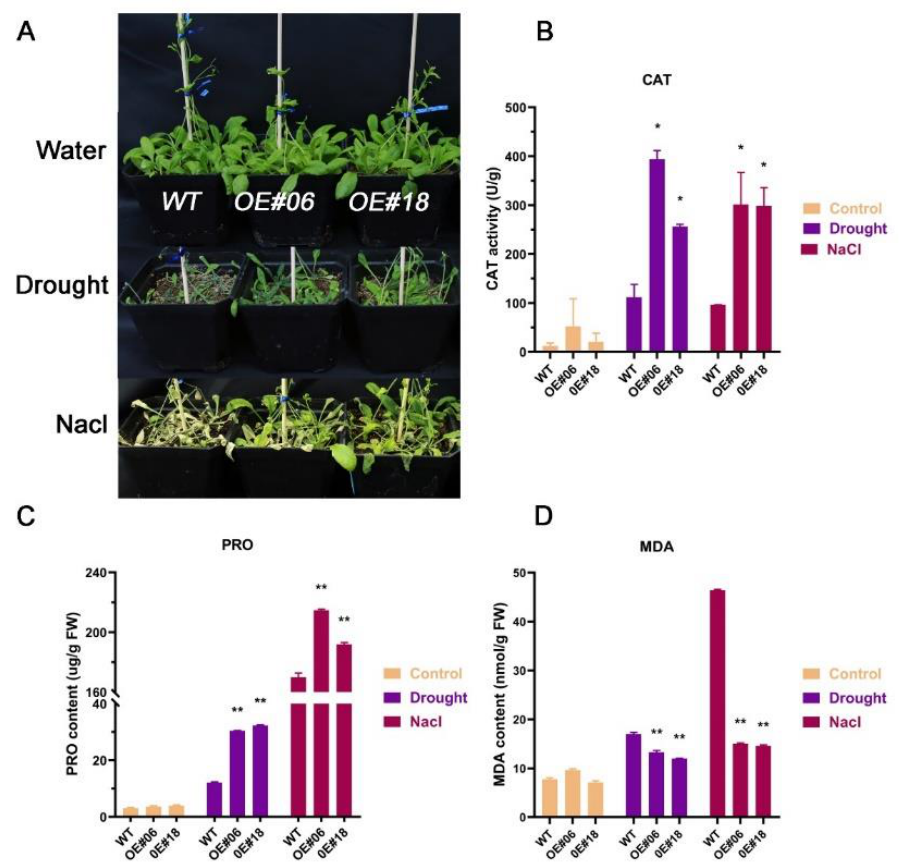
Figure 6. Effects of drought and NaCl on phenotype and physiology of FtbZIP12 -overexpressing lines. ( A ) Phenotypic map of Arabidopsis thaliana under osmotic stress. The contents of CAT ( B ), PRO ( C ), and MDA ( D ) under stress. Each value represents three replicate experiments. Values are shown as means ± SD. * p < 0.05; ** p < 0 .01 (Student’s t -test).